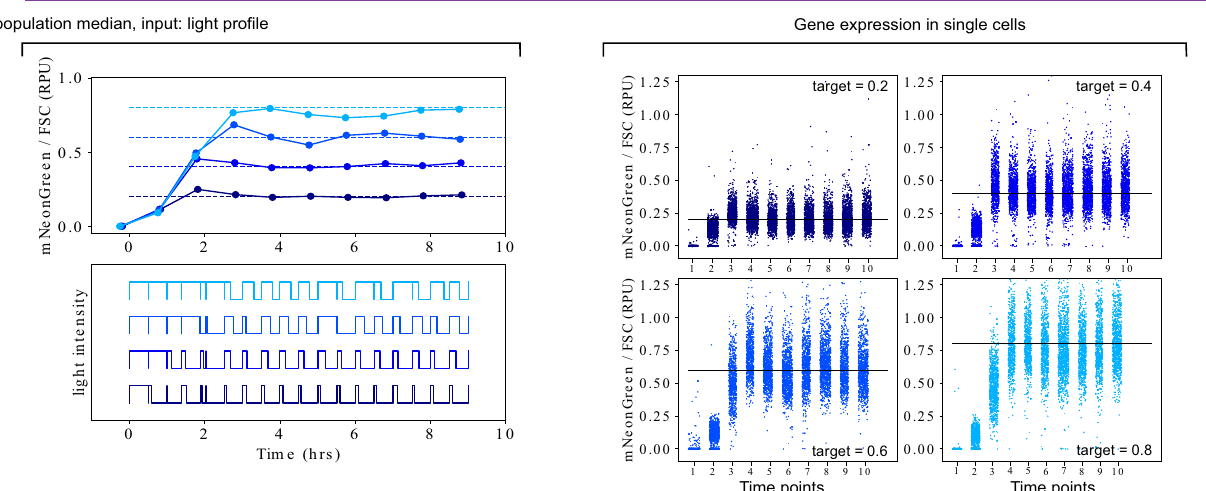
Cytometry acquisition for all reactors (every